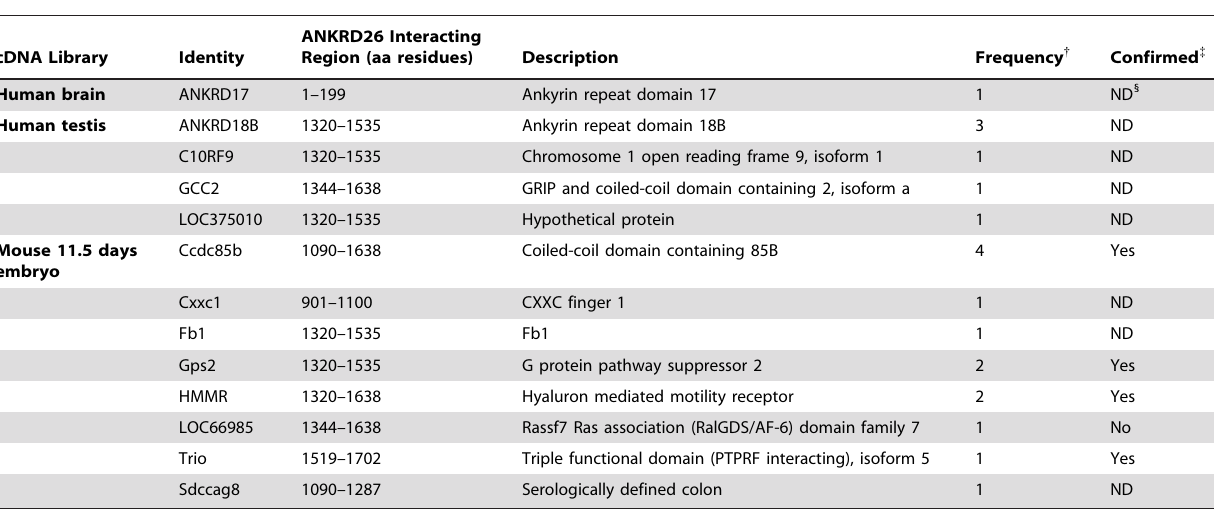
Table 1. Interactors for ANKRD26 identified by yeast two-hybrid